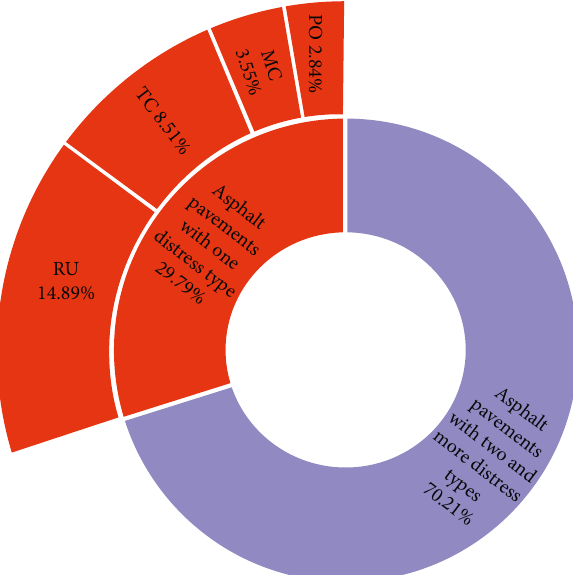
Figure 3: Proportions of asphalt pavements with different distress- type